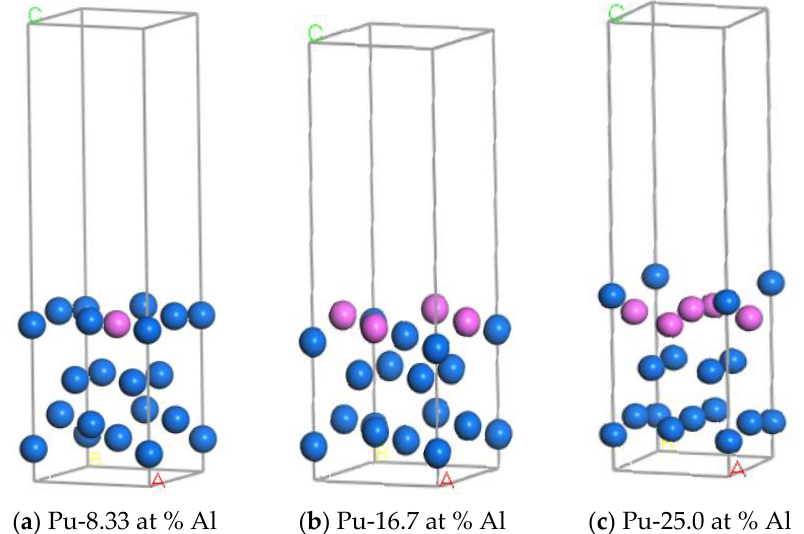
Figure 4. The relaxed Pu-Al system model with different Al doping amounts.